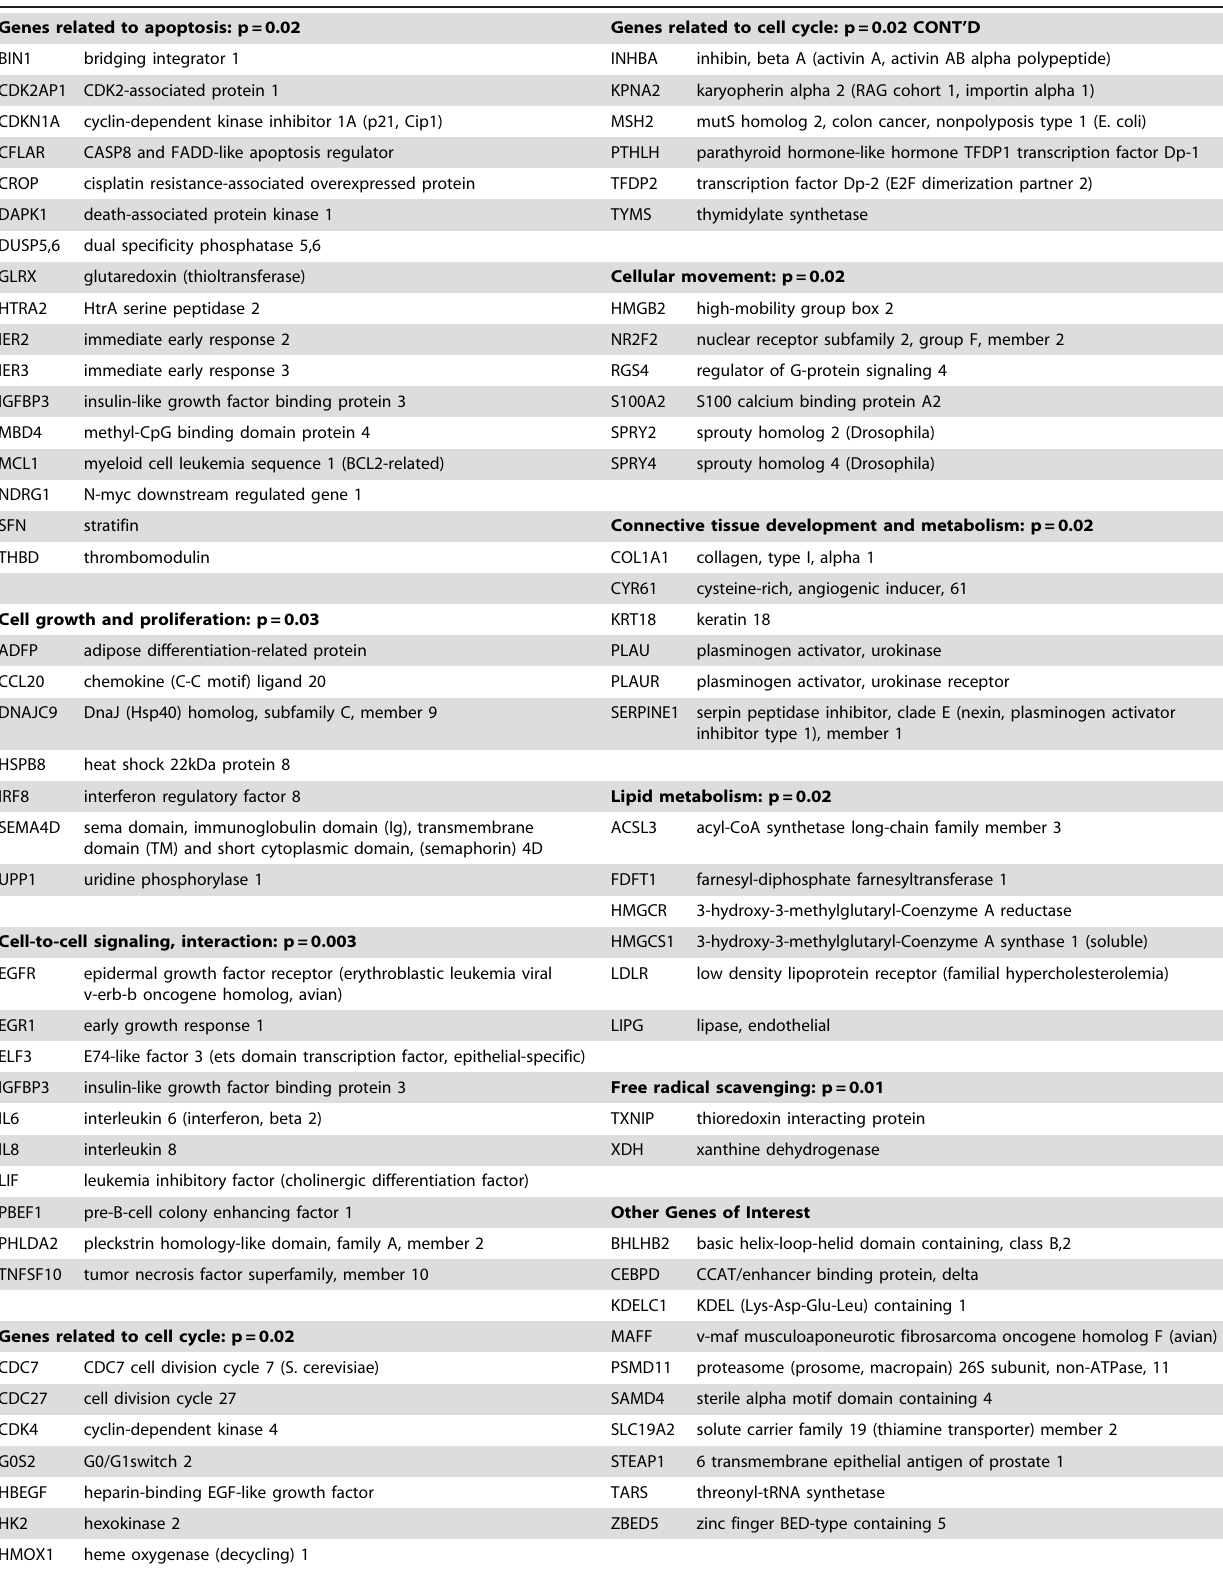
Table 1. Genes differentially expressed in cells exposed to albumin.